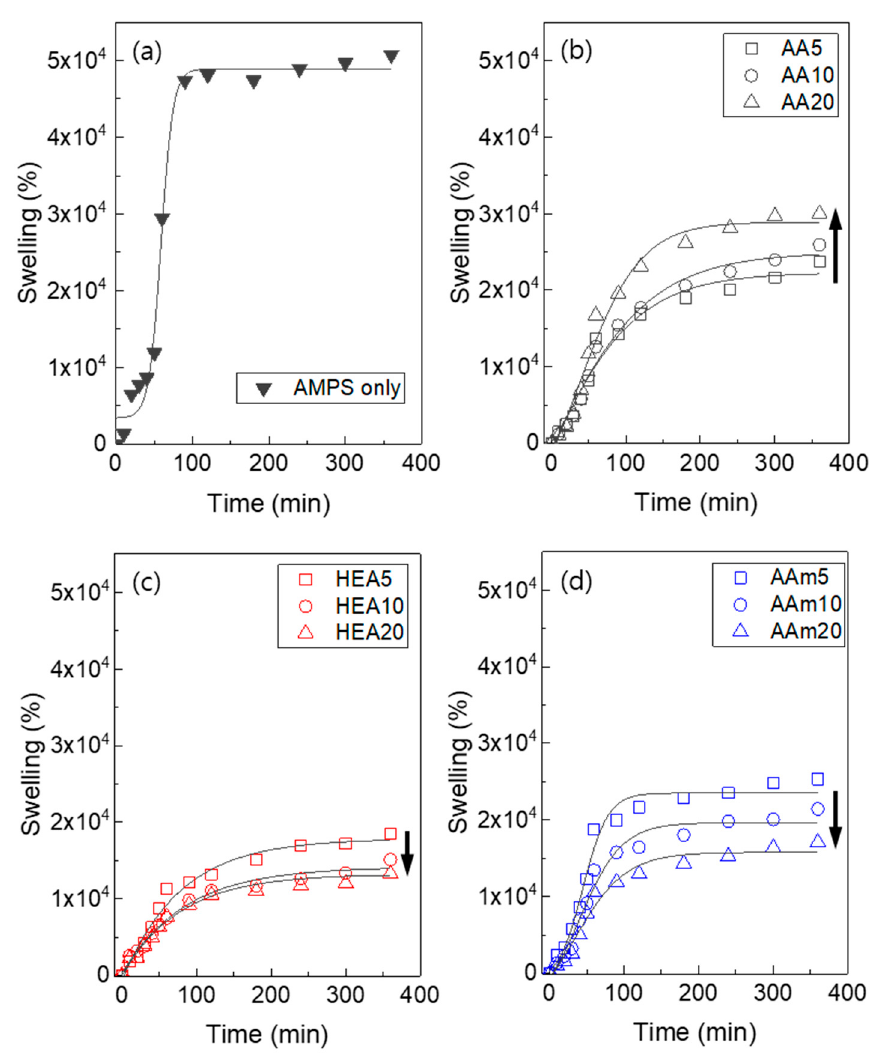
Figure 9. Swelling ratio of control AMPS hydrogel ( a ) and AMPS hydrogels modified with AA ( b ), HEA ( c ), and AAm ( d ).